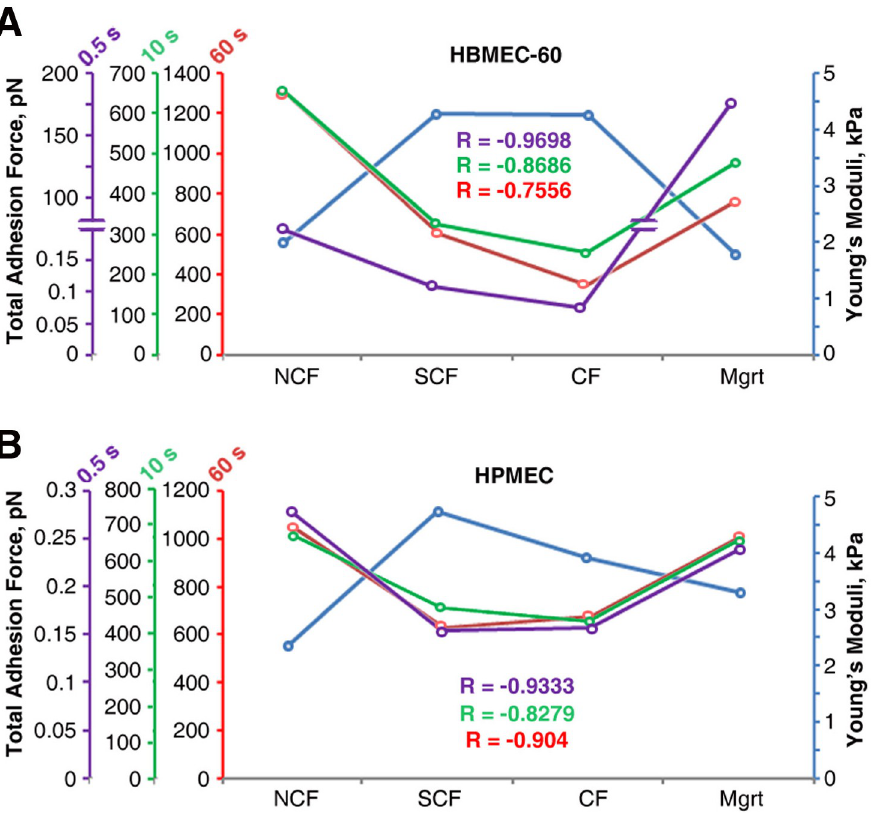
Fig 10. Regression analysis of the relationship between EC elasticity and total strength of adhesion with MB231 cells at NCF, SCF, CF and Mgrt states for three (0.5, 10 and 60 sec) cell contact times. For both HBMEC-60 (A) and HPMEC (B) there is a very strong negative correlation between elasticity and total strength of adhesion with MB231 at all three cell contact times with correlation coefficient (R) ranging from -0.76 to -0.97 for HBMEC-60 and from -0.83 to -0.93 for